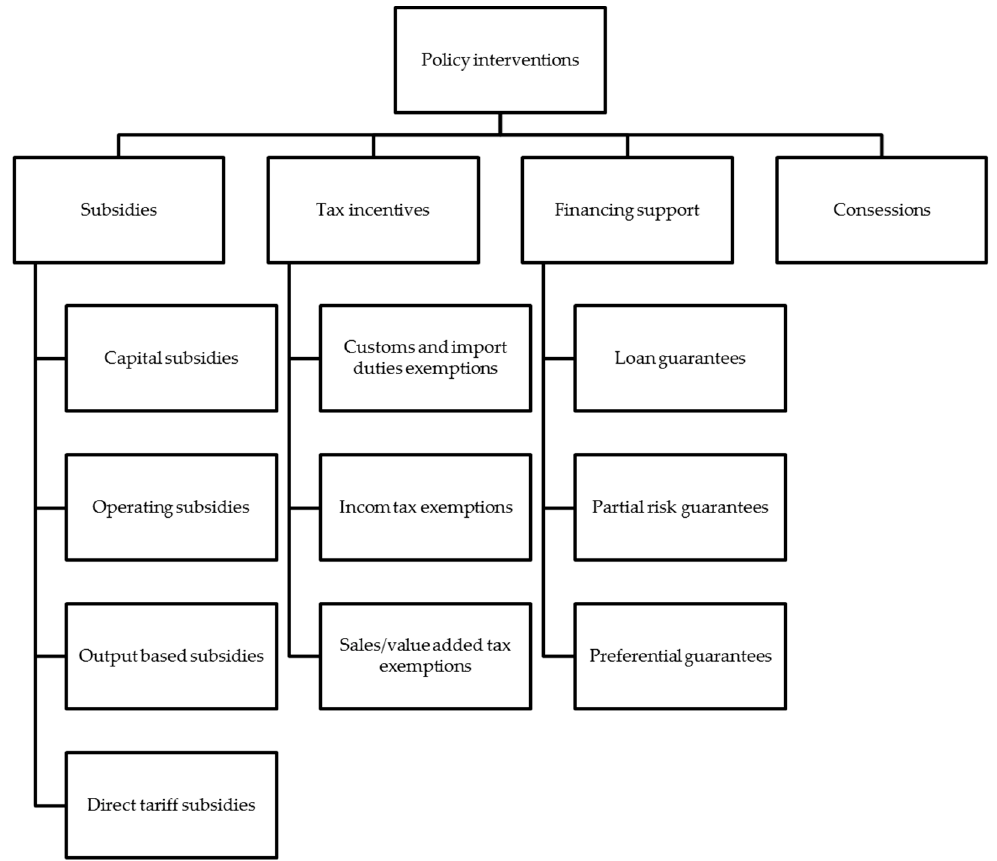
Figure 19. Policy interventions in support of wind power system.